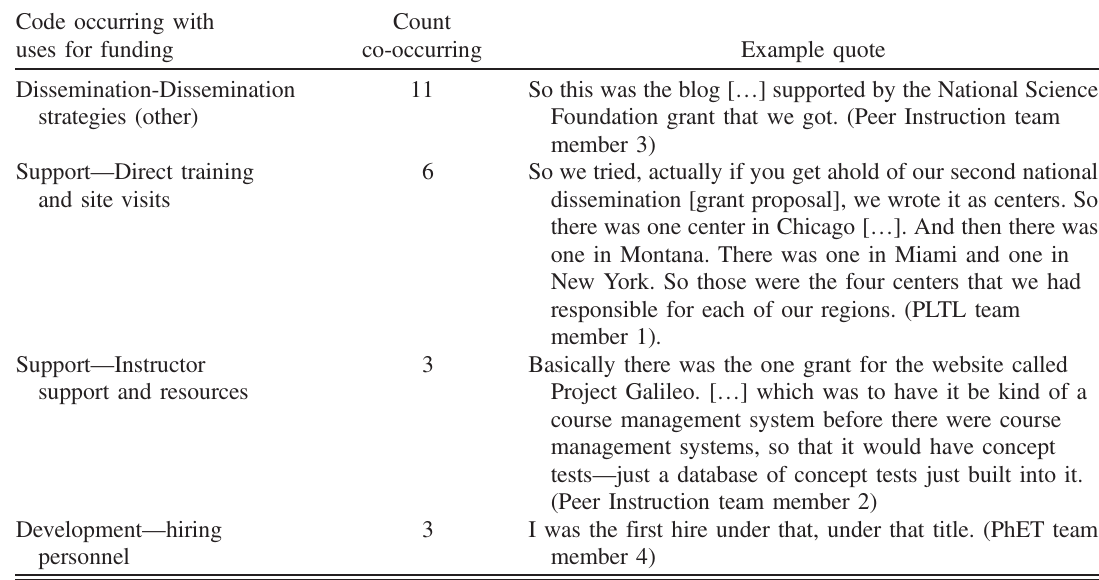
teams. Below is a table (Table X) that presents the top action codes overlapping with “ uses for funding. ”